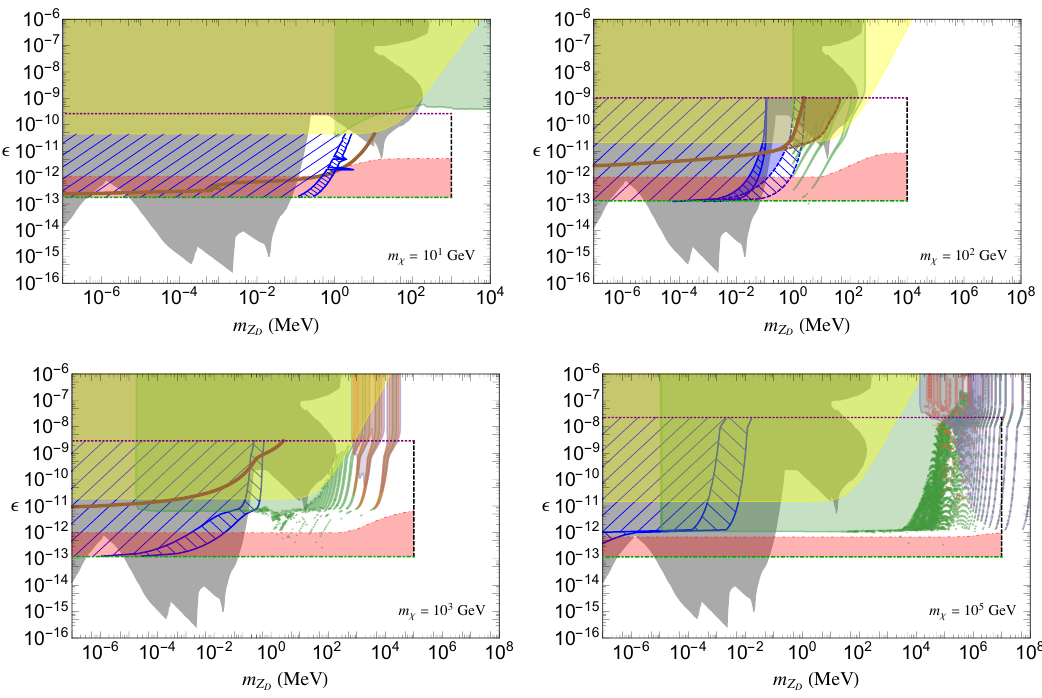
Figure 11. Observational constraints and surviving parameter space for B (cid:0) L leak-in dark matter in the (cid:15) versus m Z plane, for (cid:12)xed choices of m (cid:31) ( Upper left: m (cid:31) = 10 GeV; Upper right: D m (cid:31) = 100 GeV; Lower left: m (cid:31) = 1 TeV; Lower right: m (cid:31) = 100 TeV). Colors are as in (cid:12)gure 10; in addition constraints from H.E.S.S. are shown in purple, and Fermi dwarfs in red. The blue hatched region shows regions with h (cid:27) T i =m (cid:31) > 50 cm 2 = g (left curve) and 10 cm 2 = g (right curve), computed in the non-perturbative regime (section 4.4). In the upper right panel, for both dwarf and ellipticity constraints, solid lines denote known underestimates and dashed lines known overestimates; a full calculation in the resonant regime would yield a constraint in the shaded region in between.